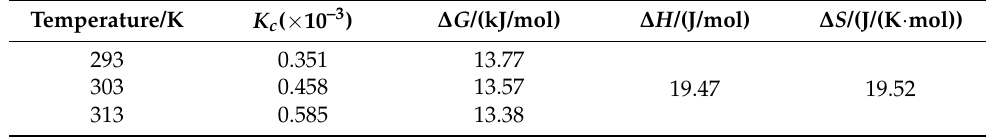
Table 3. Thermodynamic parameters of polycarboxylate water reducer onto LBSP.